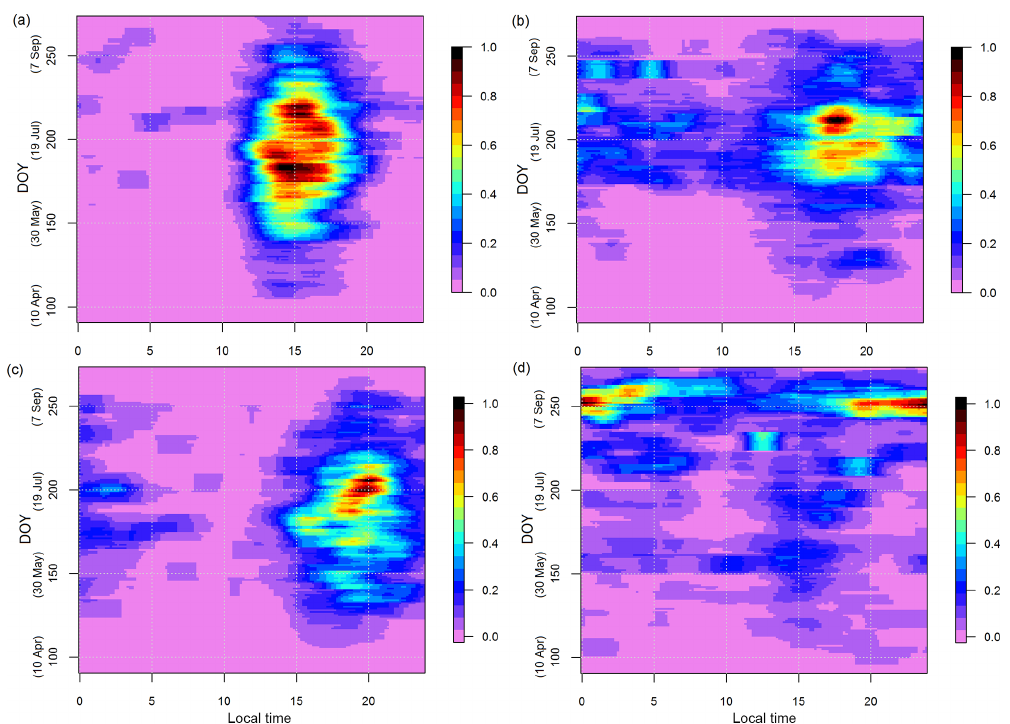
Figure 6. Average flash number as a function of local time (10min intervals) and day of year, normalized by the maximum values for the regions Maritime Alps (a) , Ticino (b) , Bavarian Prealps (c) , and Côte d’Azur (d) . Data have been smoothed applying a 10-day and 100min running